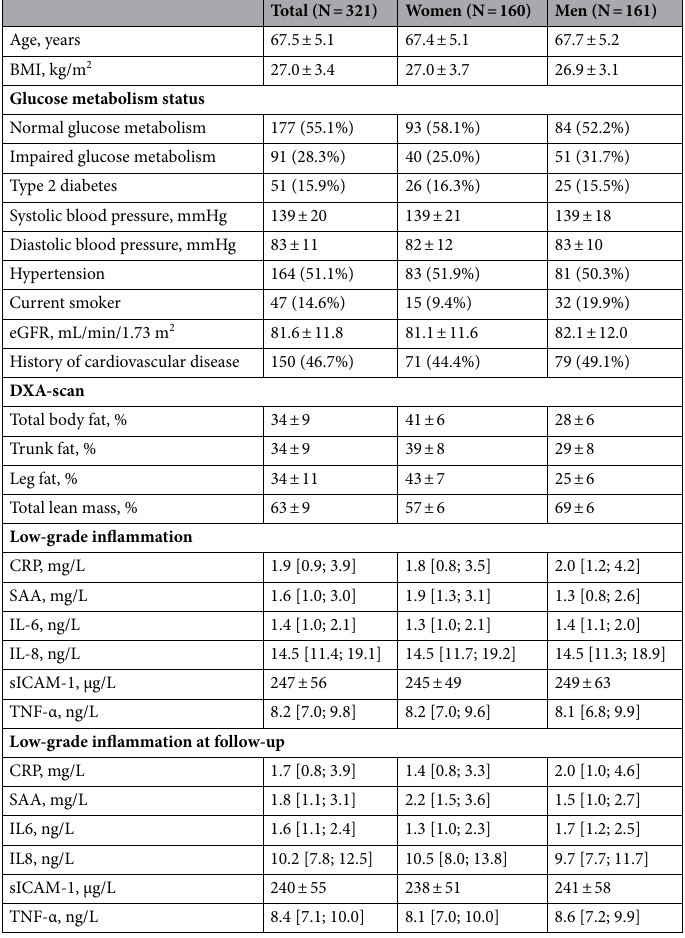
Table 1. Baseline population characteristics, DXA parameters and biomarkers of inflammations for 321 female and male participants of the Hoorn Study. Values are depicted as numbers (percentages); means ± standard deviations; medians [interquartile ranges]. DXA dual-energy X-ray absorptiometry, BMI body mass index, eGFR estimated glomerular filtration rate, CRP C-reactive protein, SAA serum amyloid A, IL-6 interleukin-6, IL-8 interleukin-8, sICAM1 soluble intercellular adhesion molecule 1, TNFa tumor necrosis factor